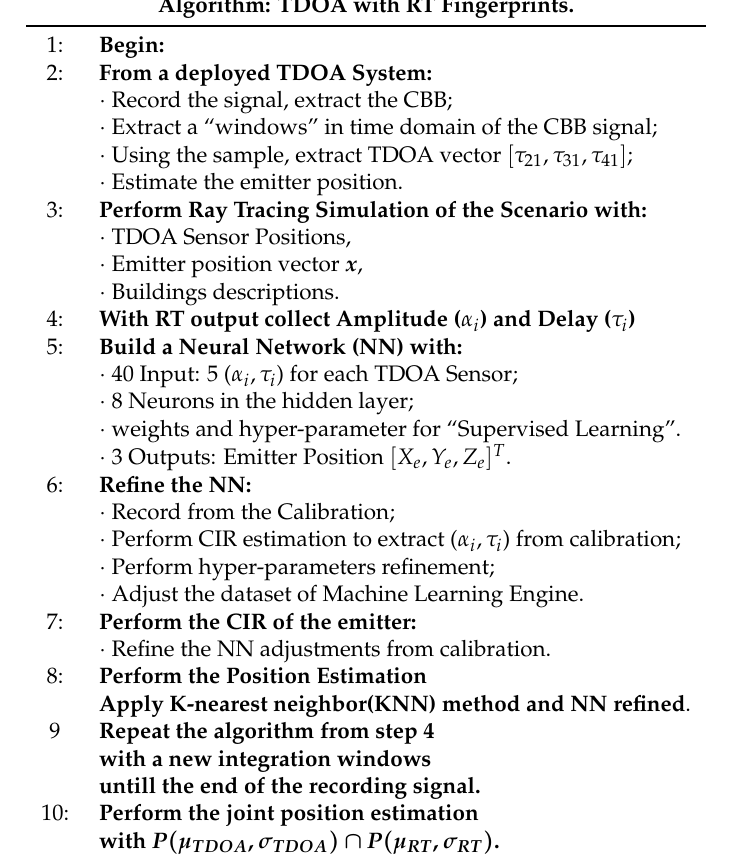
Table 1. Pseudo-code for machine learning NN fingerprints. Algorithm: TDOA with RT